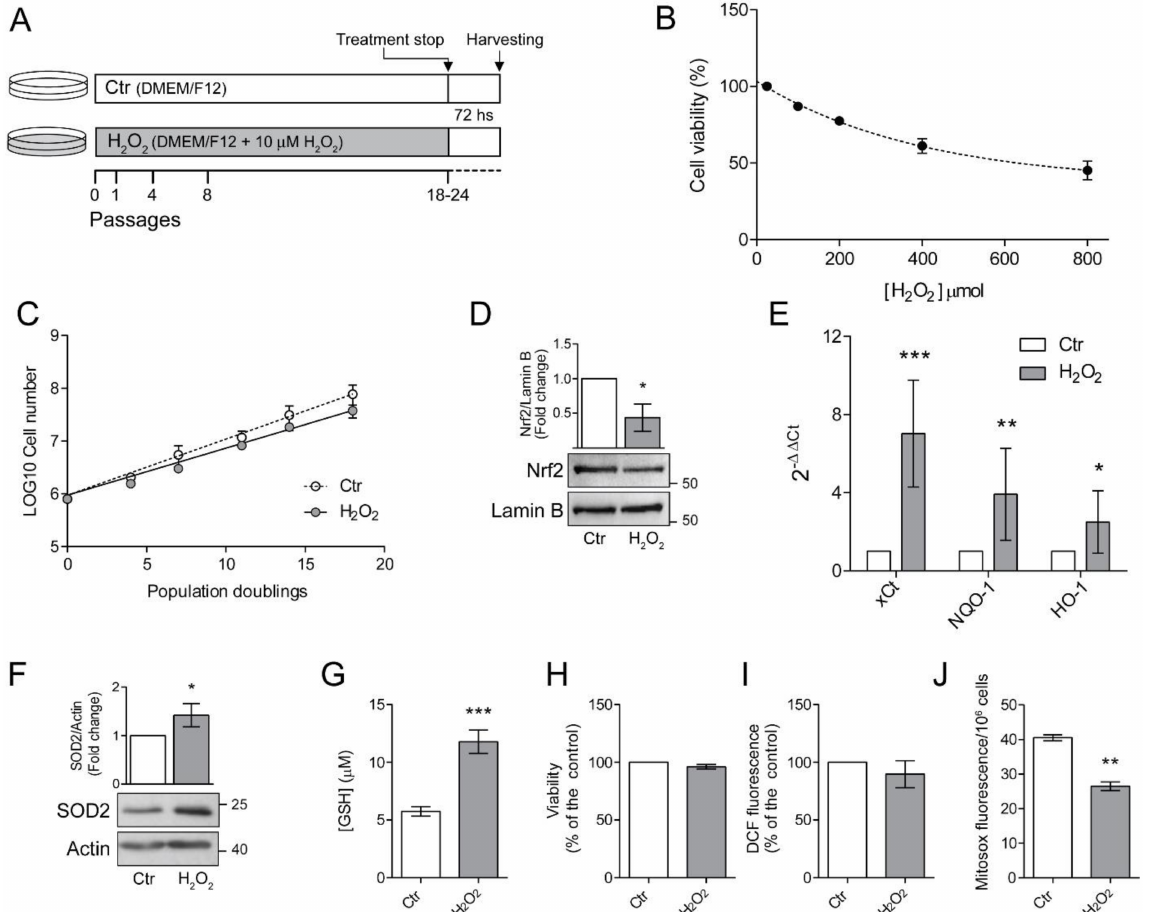
Figure 1. Chronic exposure to pro-oxidant insult increases antioxidant defences in ARPE-19 cells. ( A ) Schematic represen- tation of the experimental model. ARPE-19 cells were grown for 18–24 passages in the presence of 10 µ M H 2 O 2 (H 2 O 2 ) or left untreated (Ctr). Cells were seeded in H 2 O 2 -free medium and grown for 72 h before experiments; ( B ) ARPE-19 cell viability, determined by MTT assay, after exposure to increasing concentration of H 2 O 2 (50–800 µ M) for 48 h. Results are given as percentage of the control. Ctr and H 2 O 2 -treated cells were seeded and ( C ) cell growth was measured between p18 and p24 and reported as population doubling. Ctr and H 2 O 2 treated cells were seeded in H 2 O 2 -free medium and grown for 72 h and used for ( D ) assessment of Nrf2 nuclear translocation by western blotting. Lamin B was used as loading control. Bar graphs represent the densitometric analysis reported as the ratio between Nrf2 and Lamin B band intensity. Untreated cells were used as control and assumed as 1. One representative blot is shown and densitometric analyses are expressed as the mean ± SD of three independent experiments; ( E ) analysis of NQO-1, xCt and HO-1 gene expression by qPCR. Gene expression values were normalized to GAPDH and reported as 2 − ∆∆ Ct . Results were standardized to 1 in control samples. Data represent the mean ± SD from three independent experiments performed in triplicate; ( F ) analysis of SOD2 protein expression by Western blotting. β -actin was used as loading control. Bar graphs represent the densitometric analysis reported as the ratio between SOD2 protein and β -actin band intensity. Untreated cells were used as control and assumed as 1. One representative blot is shown and densitometric analyses are expressed as the mean ± SD of three independent experiments; ( G ) determination of GSH intracellular levels by DTNB assay. GSH level was analysed in 1 × 10 6 cells and reported as µ M. Bar graphs represent the mean ± SD of five independent experiments; ( H ) determination of cell viability by MTT assay. The absorbance of control cells was assumed as 1. Data represent the mean ± SD of three independent experi- ments; ( I ) measurement of total intracellular ROS levels by H 2 DCFDA staining ( λ ex = 485 nm; λ em = 535 nm) normalized to cell viability. Fluorescence values in control cells was assumed as 1. Data represent the mean ± SD of three independent experiments; ( J ) measurement of mitochondrial ROS by MitoSox Red staining ( λ ex = 510 nm; λ em = 600 nm). Data represent the mean ± SD of three independent experiments (* p < 0.05, ** p < 0.01, *** p <